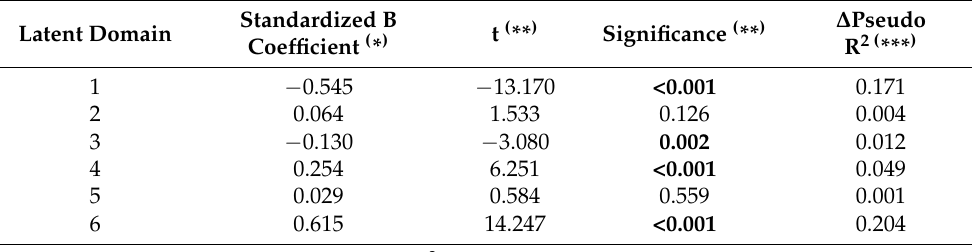
Table 6. Multiple quantile regression model of ANSIs against biochemical, body composition and autonomic latent domains in Olympic athletes: estimation and significance test for the latent domain effect sizes.